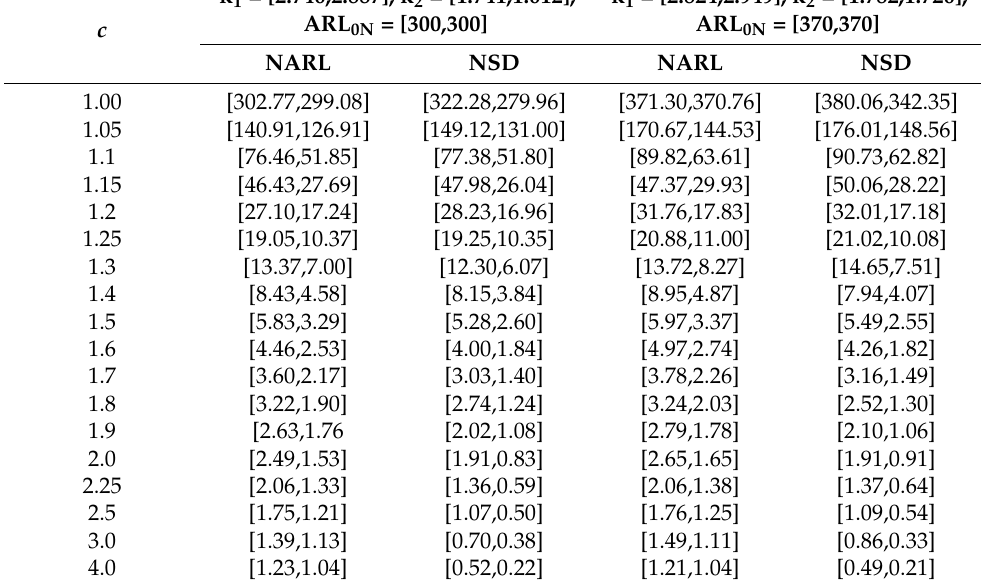
Table 2. The NARL when n N (cid:101) [3,5] and I λ U = 0.18.